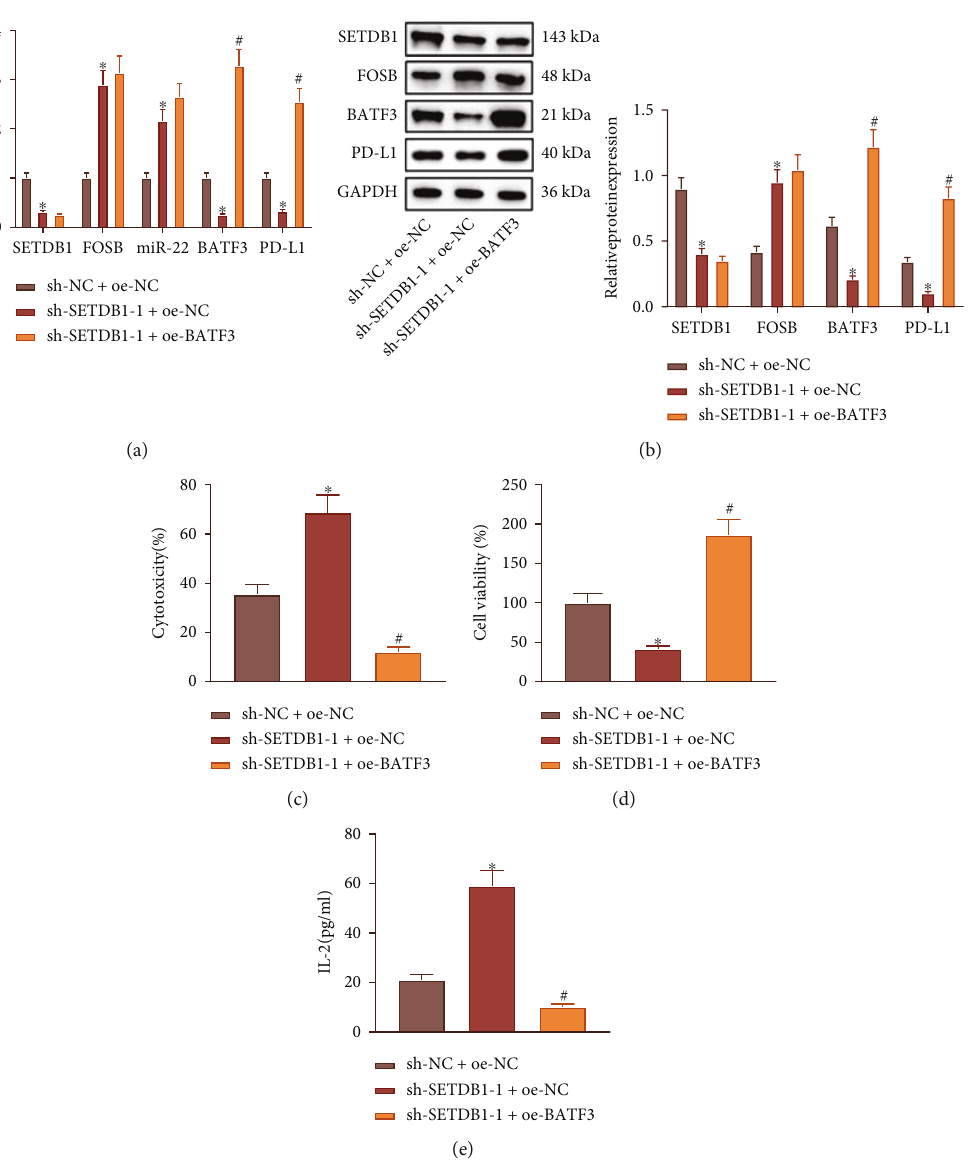
Figure 4: Silencing of SETDB1 inhibits PD-L1 expression and facilitates the T cell-mediated cytotoxicity to tumor cells via the FOSB/miR- 22/BATF3 axis. (a) The expression of SETDB1, FOSB, miR-22, BATF3, and PD-L1 in SW480 cells treated with sh-SETDB1 or combined with OE-BATF3 determined by RT-qPCR. (b) The protein expression of SETDB1, FOSB, BATF3, and PD-L1 in SW480 cells treated with sh-SETDB1 or combined with OE-BATF3 normalized to GAPDH determined by Western blot analysis. (c) T cell cytotoxicity determined by the LDH test kit following treatment with sh-SETDB1 or combined with OE-BATF3. (d) The viability of SW480 cells treated with sh-SETDB1 or combined with OE-BATF3 detected by CCK-8 assay. (e) The content of IL-2 in the cell supernatant following treatment with sh-SETDB1 or combined with OE-BATF3 determined by ELISA. ∗ p < 0 : 05 vs. SW480 cells treated with sh-NC +OE-NC. # p < 0 : 05 vs. SW480 cells treated with sh-SETDB1-1+OE-NC. The cell experiment was run in triplicate